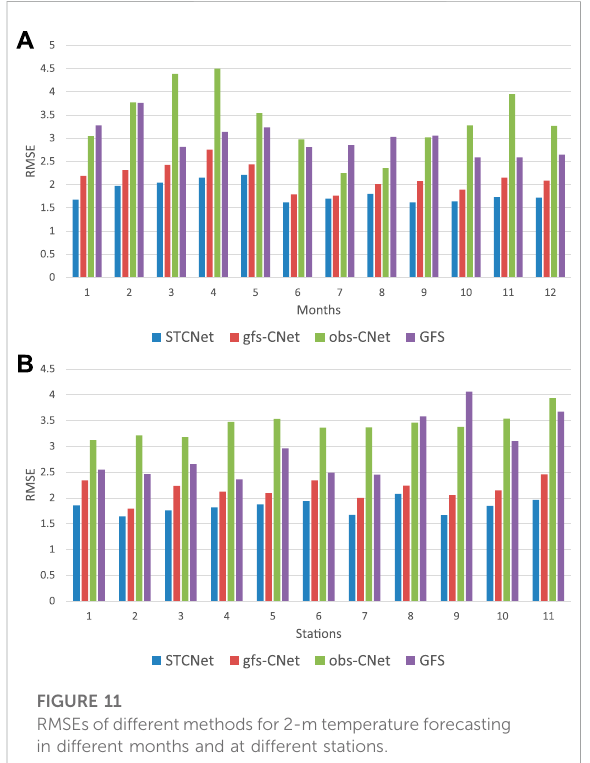
FIGURE 12 Comparison of the forecast and actual values with respect to hourly 2-m temperature